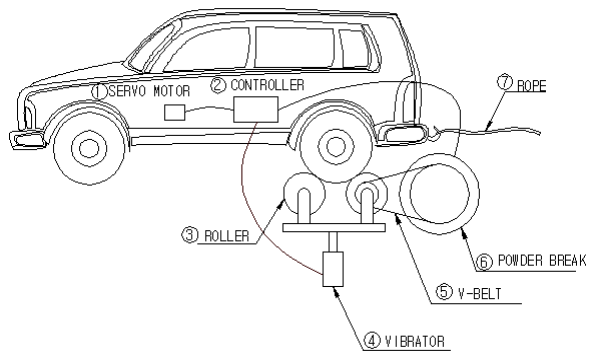
Figure 18. CVT data.